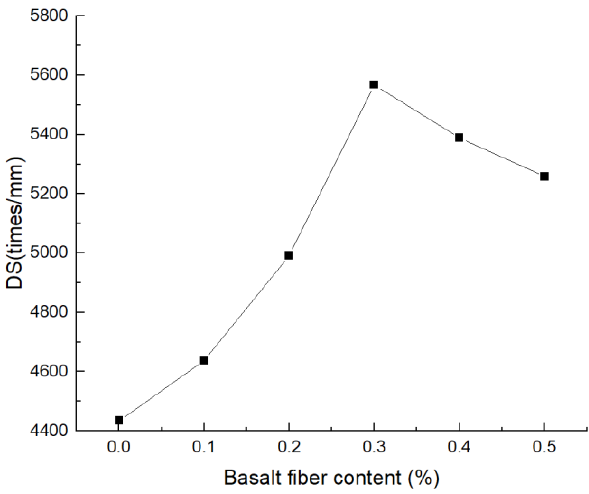
Figure 4. Dynamic stability (DS) of asphalt mixture containing variousdosages of basalt fiber.